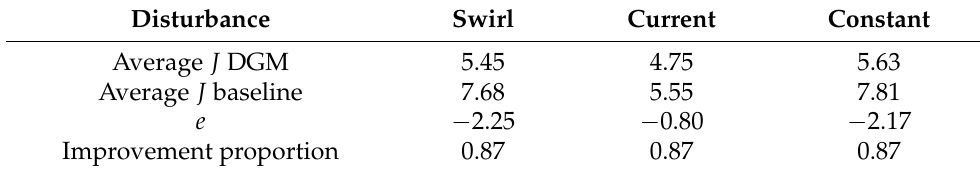
Table 2. Results for the original OCP (10), comparing DGM and the baseline control. The DGM provides better results, not only in terms of lower cost and average error (remember that negative error values mean that the DGM is better), but also in that more than 85% of the trajectories present a lower cost with the